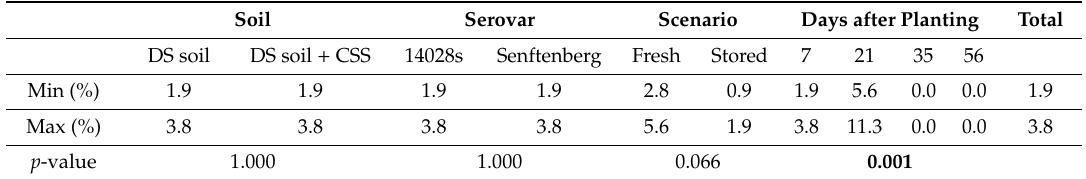
Table 2. Salmonella enterica colonized plants expressed as a percentage of the tested population. Phyllosphere of B. rapa plants was tested for the presence of Salmonella using the Bu ff ered Peptone Water enrichment technique followed by Salmonella -specific cultivation in the Rappaport–Vassiliadis broth. Both enrichments were plated on XLD plates supplemented with rifampicin to verify Salmonella’s presence. We tested n = 678 plants. Two plants were pooled together in order to reduce the number of samples. This results in the min. (%) and max. (%) number of colonized plants. Significant di ff erences were calculated using one-way ANOVA and are highlighted in bold ( p ≤ 0.05). Soil Serovar Scenario Days after Planting Total DS soil DS soil + CSS 14028s Senftenberg Fresh